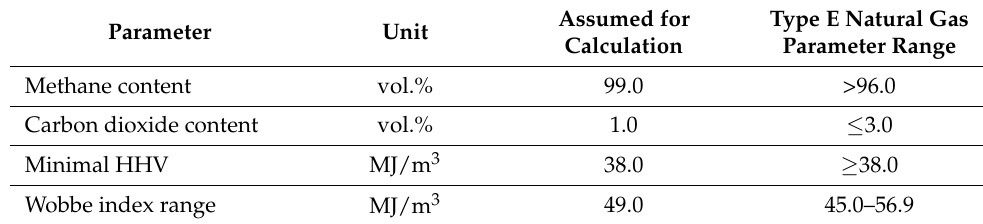
Table 5. Physicochemical properties of natural